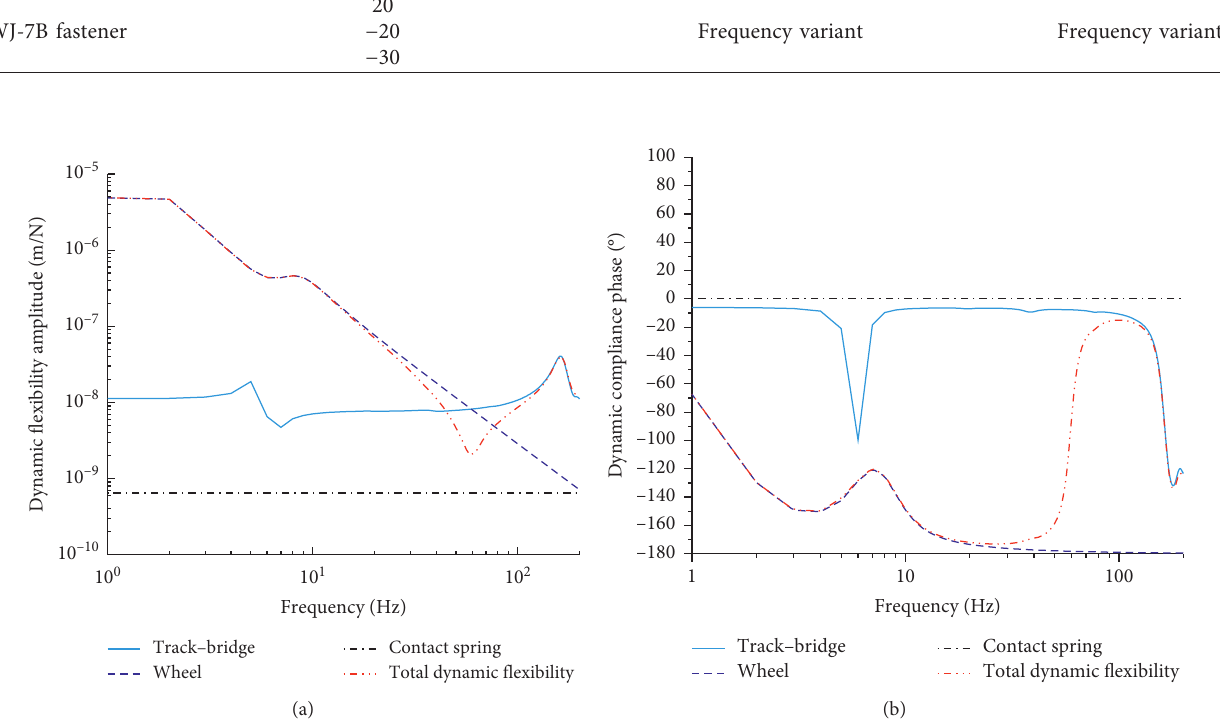
Figure 11: Dynamic compliance amplitude and phase of vehicle-track-bridge system with rubber pad at 20 ° C: (a) amplitude; (b) phase.